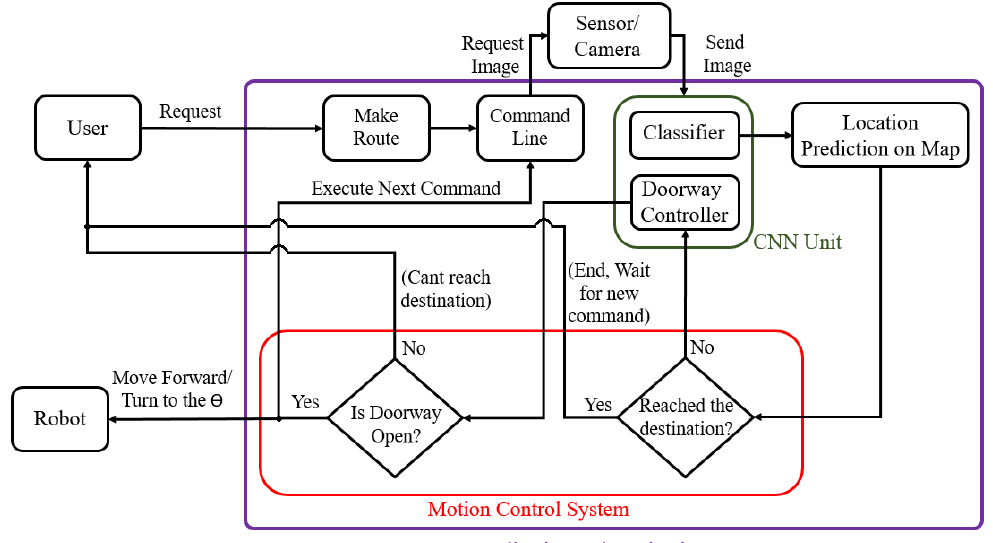
Figure 4. The proposed approach’s